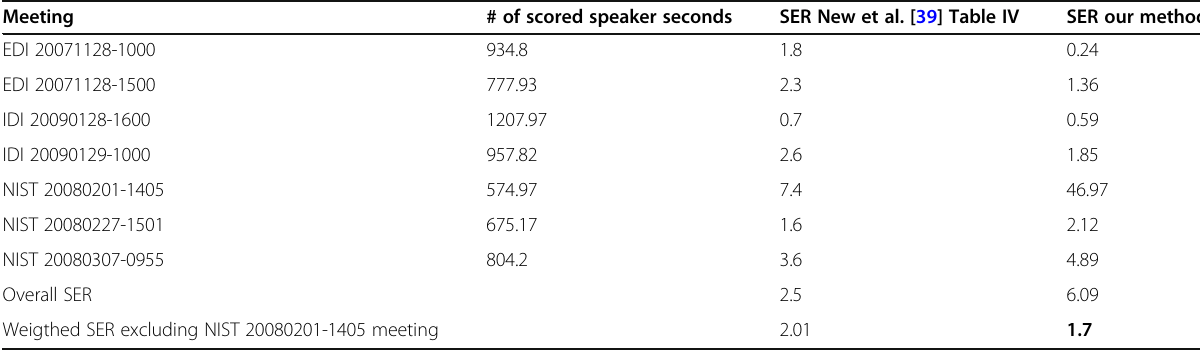
Table 14 Comparison of our results for RT09 with other published results [39] Meeting # of scored speaker